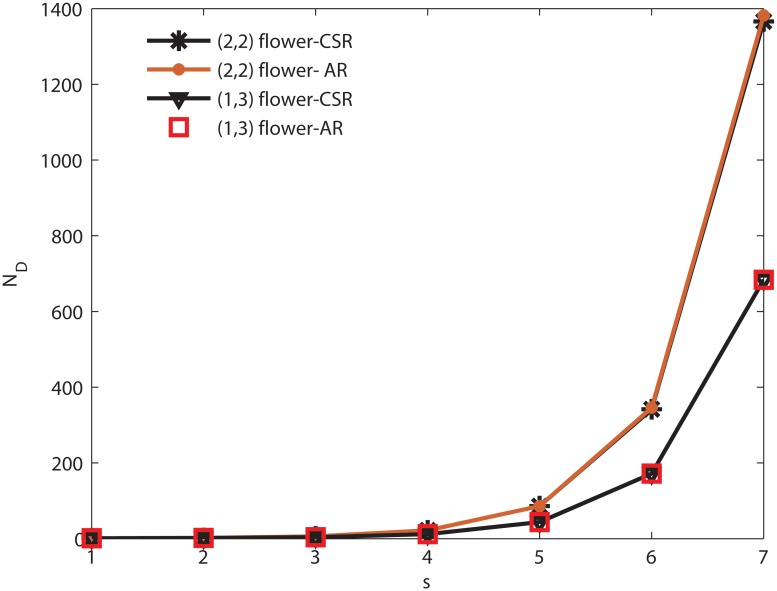
The minimum number of driver nodes N
D of the two networks increased with s.CSR denotes the results by computer simulation. AR denotes the results predicted by Eqs (11) and (16) in two networks. Two networks are iterated to step 7. For the two networks, the CSR and AR are exactly same, respectively. But the N
D of the (2, 2)-flower network is more than the (1, 3)-flower network.